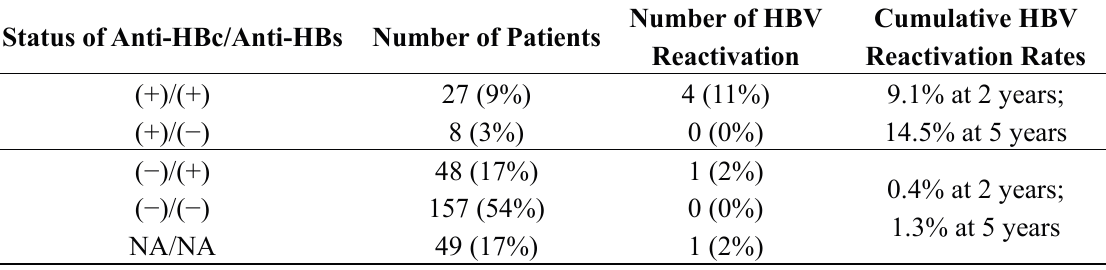
Table 1. Prevalence of antibodies to hepatitis B core antigen (anti-HBc) and to hepatitis B surface antigen (anti-HBs), and hepatitis B virus (HBV) reactivation rates in the 289 hepatitis B surface antigen (HBsAg)-negative recipients with hematopoietic stem cell transplantation (HSCT) in 2000 or